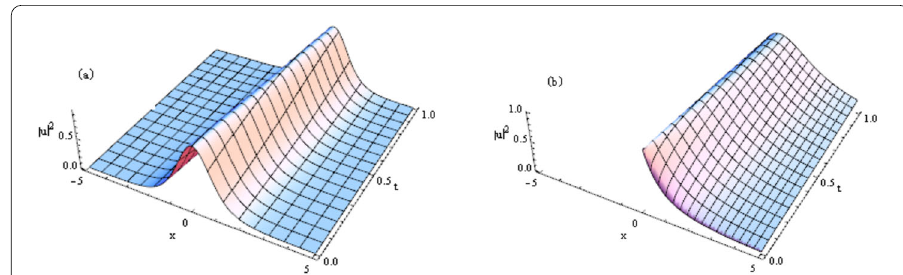
Figure 2 ( a ) The evolution plot of the bell-shaped solitary wave solutions u 11 with the parameters when k = k